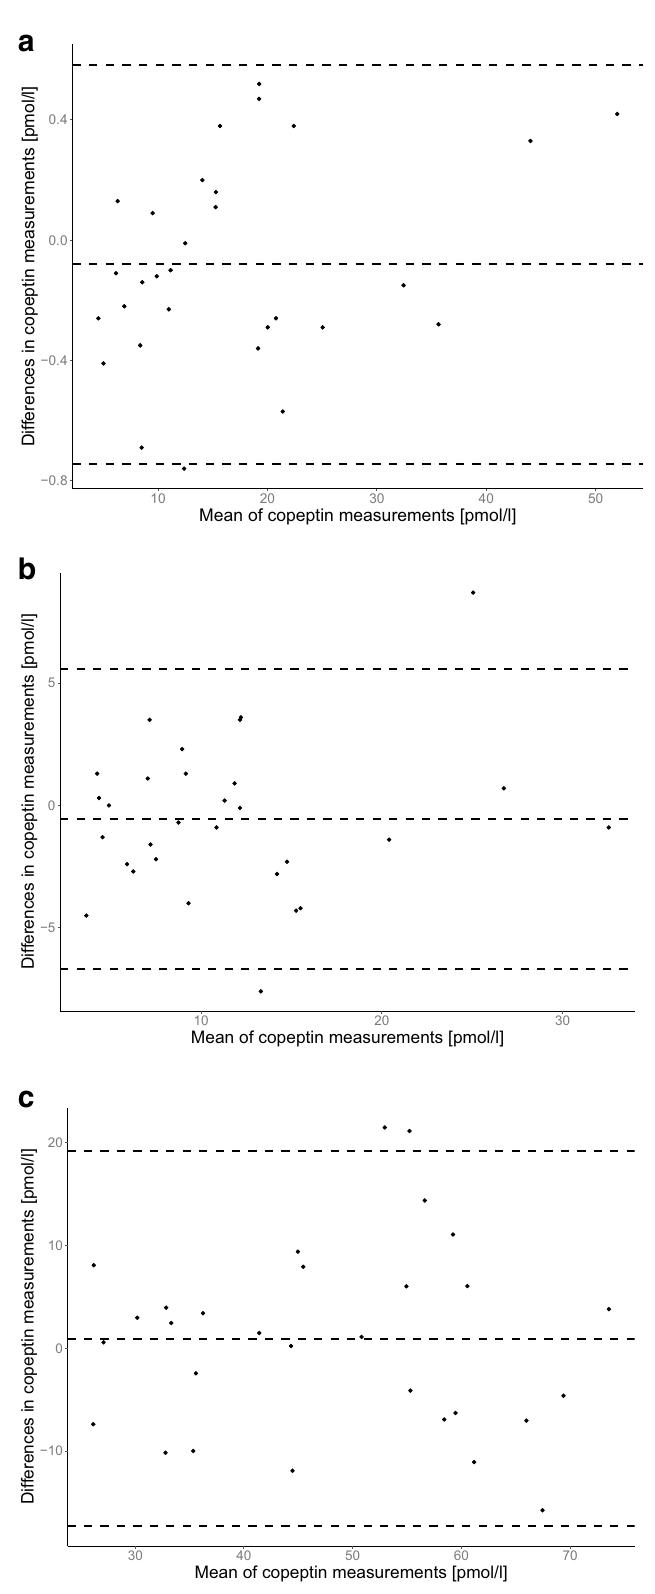
Figure 1. Intra-assay difference in copeptin concentrations in healthy volunteers. Bland–Altman graph of intra-assay difference in copeptin concentrations in healthy volunteers for ( a ) the KRYPTOR, ( b ) the LIA and ( c ) the ELISA. The dotted middle line represents the mean difference in copeptin concentrations between the two different assays ( a ): − 0.08 pmol/l (95% limits − 0.75 to 0.48), ( b ): − 0.55 pmol/l (95% limits − 6.69 to 5.59), ( c ): 0.92 pmol/l (95% limits − 17.32 to 19.16)). The outer dotted lines represent the 95% confident interval limits of agreement. ( a ) KRYPTOR 1 vs KRYPTOR 2, ( b ) LIA 1 vs LIA 2, ( c ) ELISA 1 vs ELISA